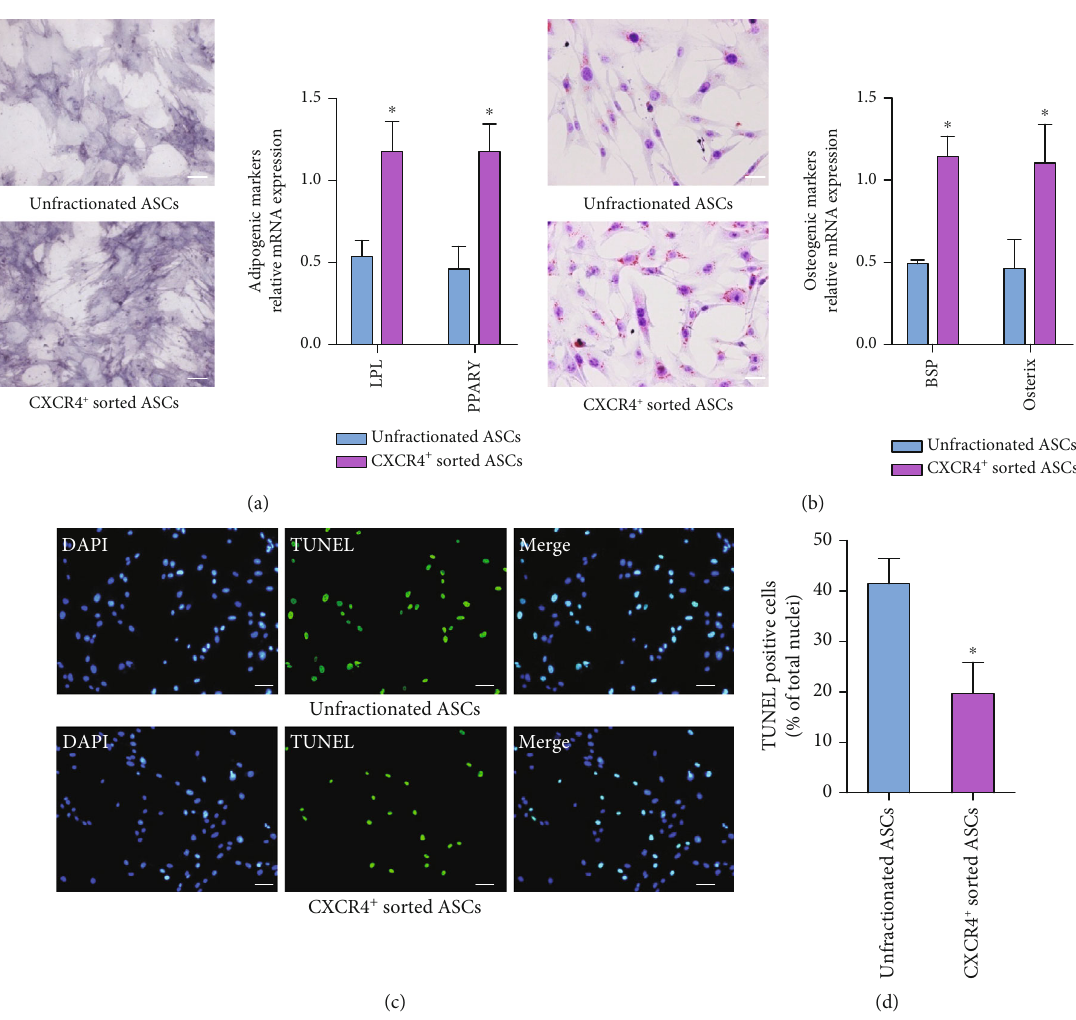
Figure 4: CXCR4 + sorted ASCs expressed higher levels of osteogenic and adipogenic marker mRNA and had lower percentage of OGD- induced apoptosis in vitro. (a) Osteocyte lineage di ff erentiation potential was demonstrated by AP staining. CXCR4 + sorted ASCs exhibited the markedly increased mRNA expression of BSP and osterix in comparison with unfractionated ASCs. (b) Oil Red O staining indicated the accumulation of oil droplets in cells that di ff erentiated to adipocytes. LPL and PPAR γ mRNA expressions were more detectable in CXCR4 + sorted ASCs as compared to unfractionated ASCs. (c) Apoptotic cell death was assessed by TUNEL staining (red fl uorescence), and cell nuclei were visualized with DAPI staining (blue). OGD-induced cell apoptosis was more frequent in CXCR4 + sorted ASCs than in unfractionated ASCs. Scale bar represents 50 μ m. ∗ p < : 05 versus unfractionated ASCs. Abbreviations: